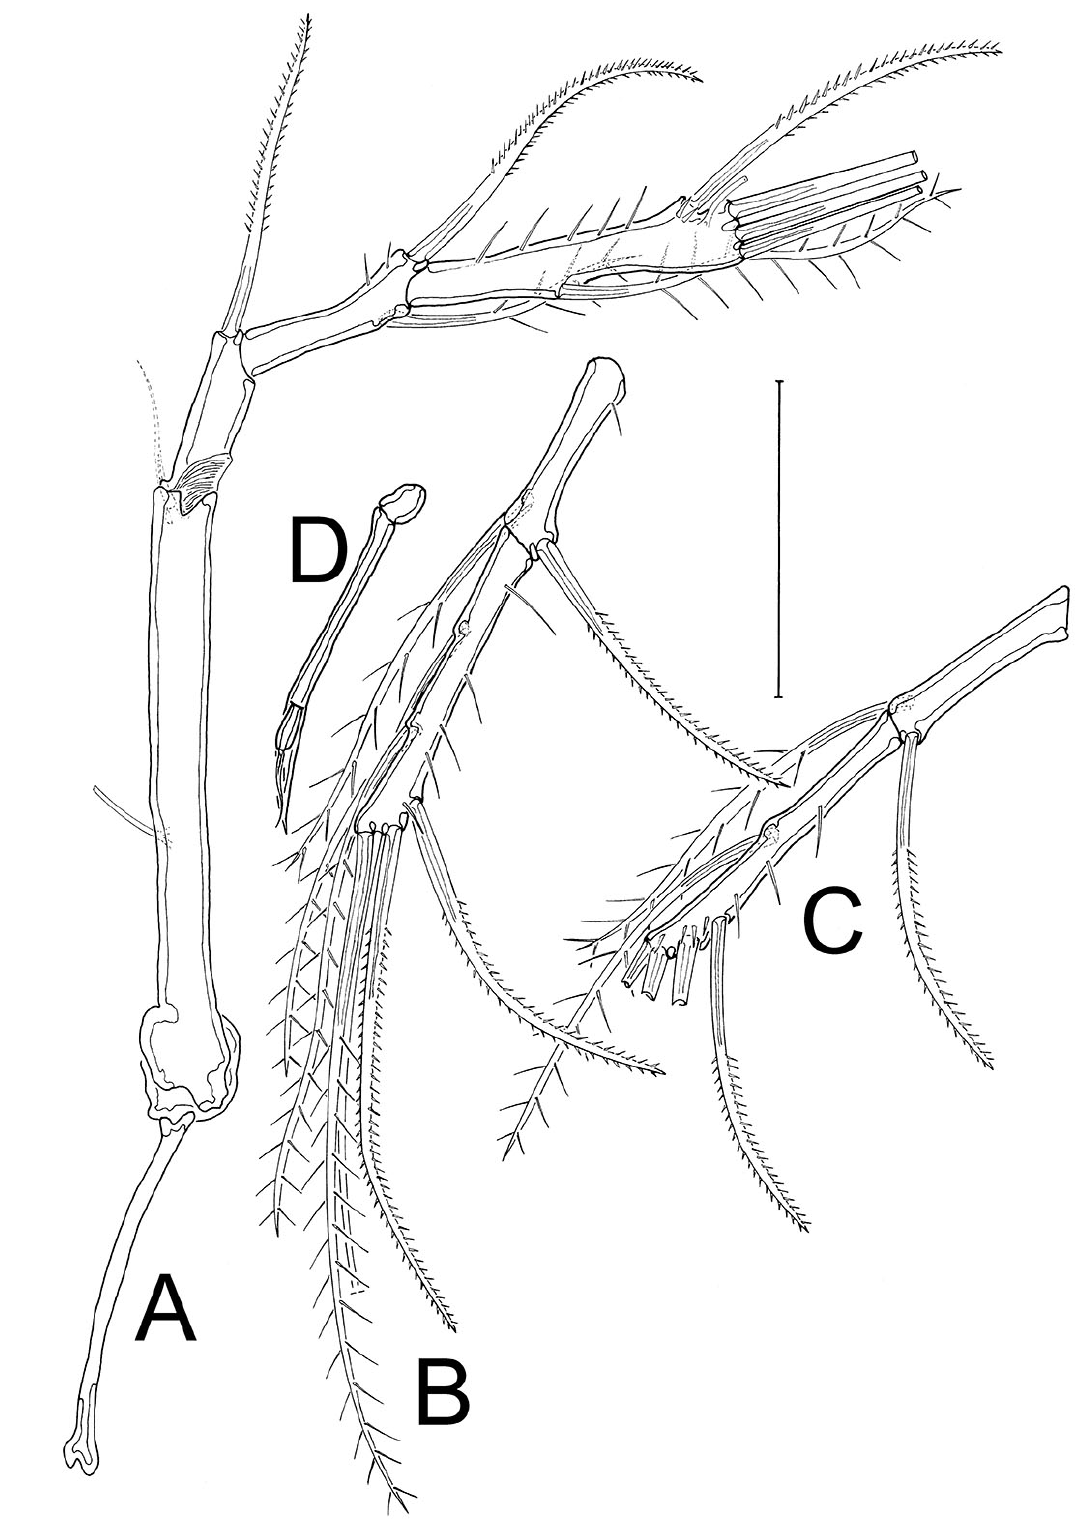
Fig. 6. Poropsyllus menzelae gen. et sp. nov. A–C . Female holotype (HUJ INVCRUCOP808). A . P2. B . P3 exp-2 and exp-3. C . P4 exp-2 and exp-3. D . Male allotype (HUJ INVCRUCOP809), P3 endopod. Scale bar: 50